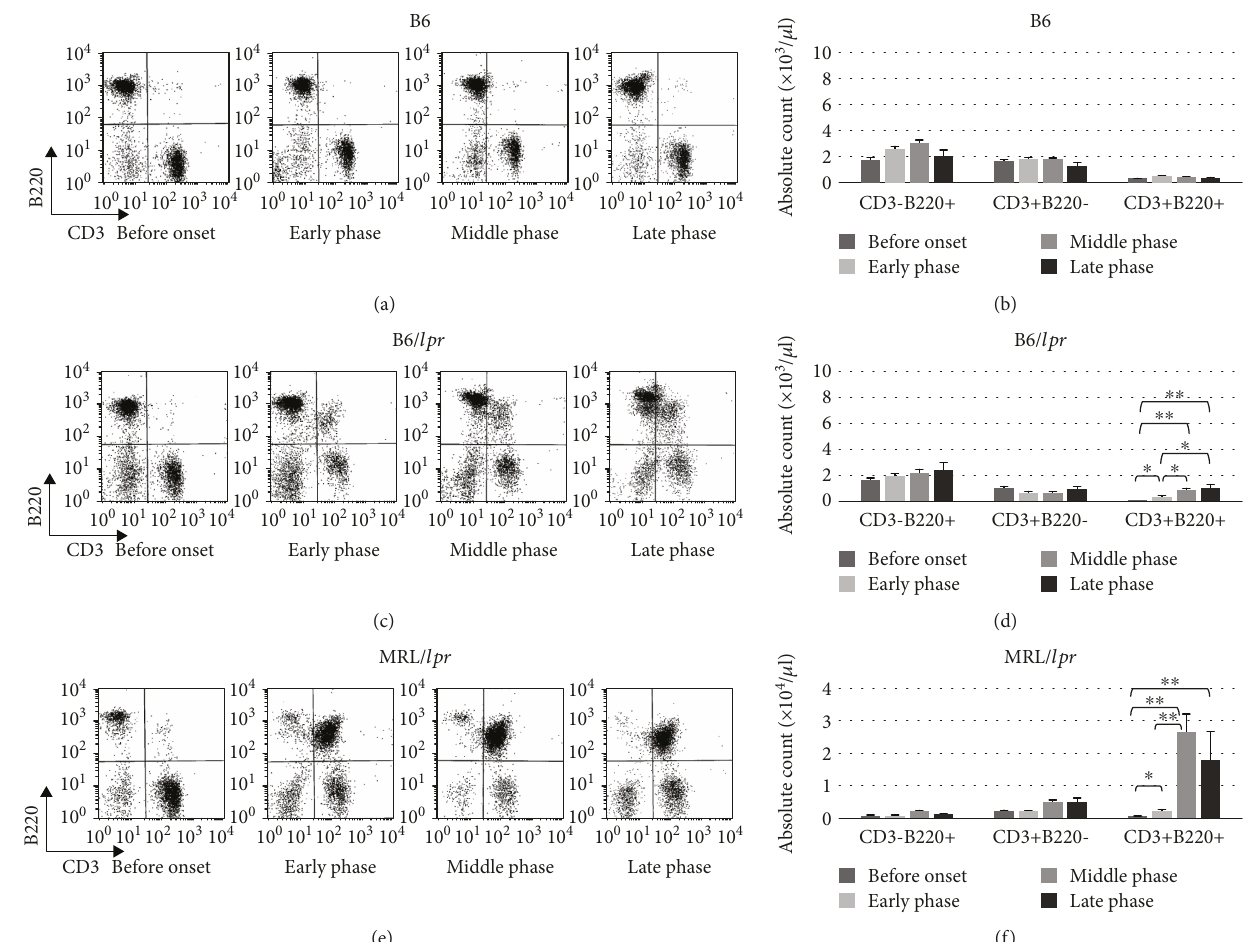
Figure 3: Expression of CD3 and B220 in peripheral blood. Peripheral blood cells obtained from the B6 mice ( n = 32 ) were stained and analyzed with fl ow cytometry. Representative fl ow cytometry plots (a) and absolute count of CD3-B220+, CD3+B220-, and CD3+B220+ cells (b) are shown. Peripheral blood cells obtained from the B6/ lpr mice ( n = 35 ) were stained and analyzed with fl ow cytometry. Representative fl ow cytometry plots (c) and absolute count of CD3-B220+, CD3+B220-, and CD3+B220+ cells (d) are shown. Peripheral blood cells obtained from the MRL/ lpr mice ( n = 27 ) were stained and analyzed with fl ow cytometry. Representative fl ow cytometry plots (e) and absolute count of CD3-B220+, CD3+B220-, and CD3+B220+ cells (f) are